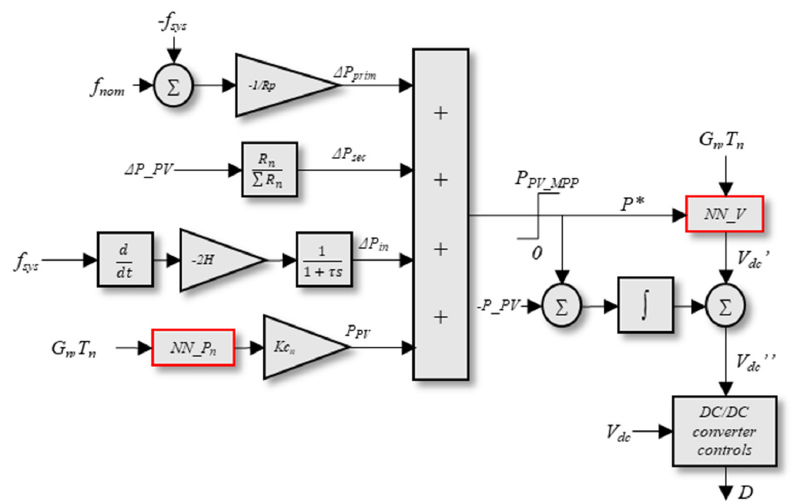
Figure 5. Array control with fixed droop, secondary control, virtual inertia control and curtail- ment control.